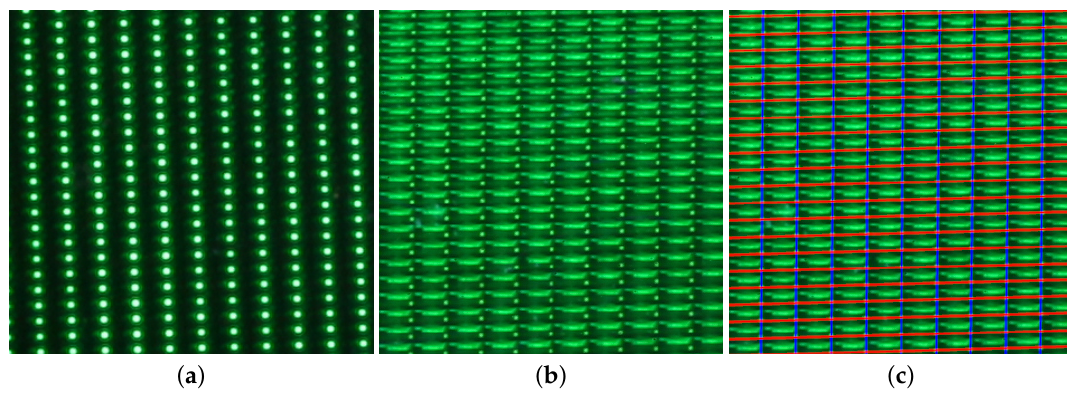
Figure 4. ( a ) camera image of the mirror array screen as seen by the naked eye when completely lit by the projector (diffuse areas are not visible); ( b ) camera image of the mirror array screen, captured using a dedicated procedure to detect diffusing markers (diffuse areas are visible as dots); ( c ) borders of the elemental images overlaid on top of the image using the estimated homography. Intersections coincide with the diffusers, which are located at the corners of the